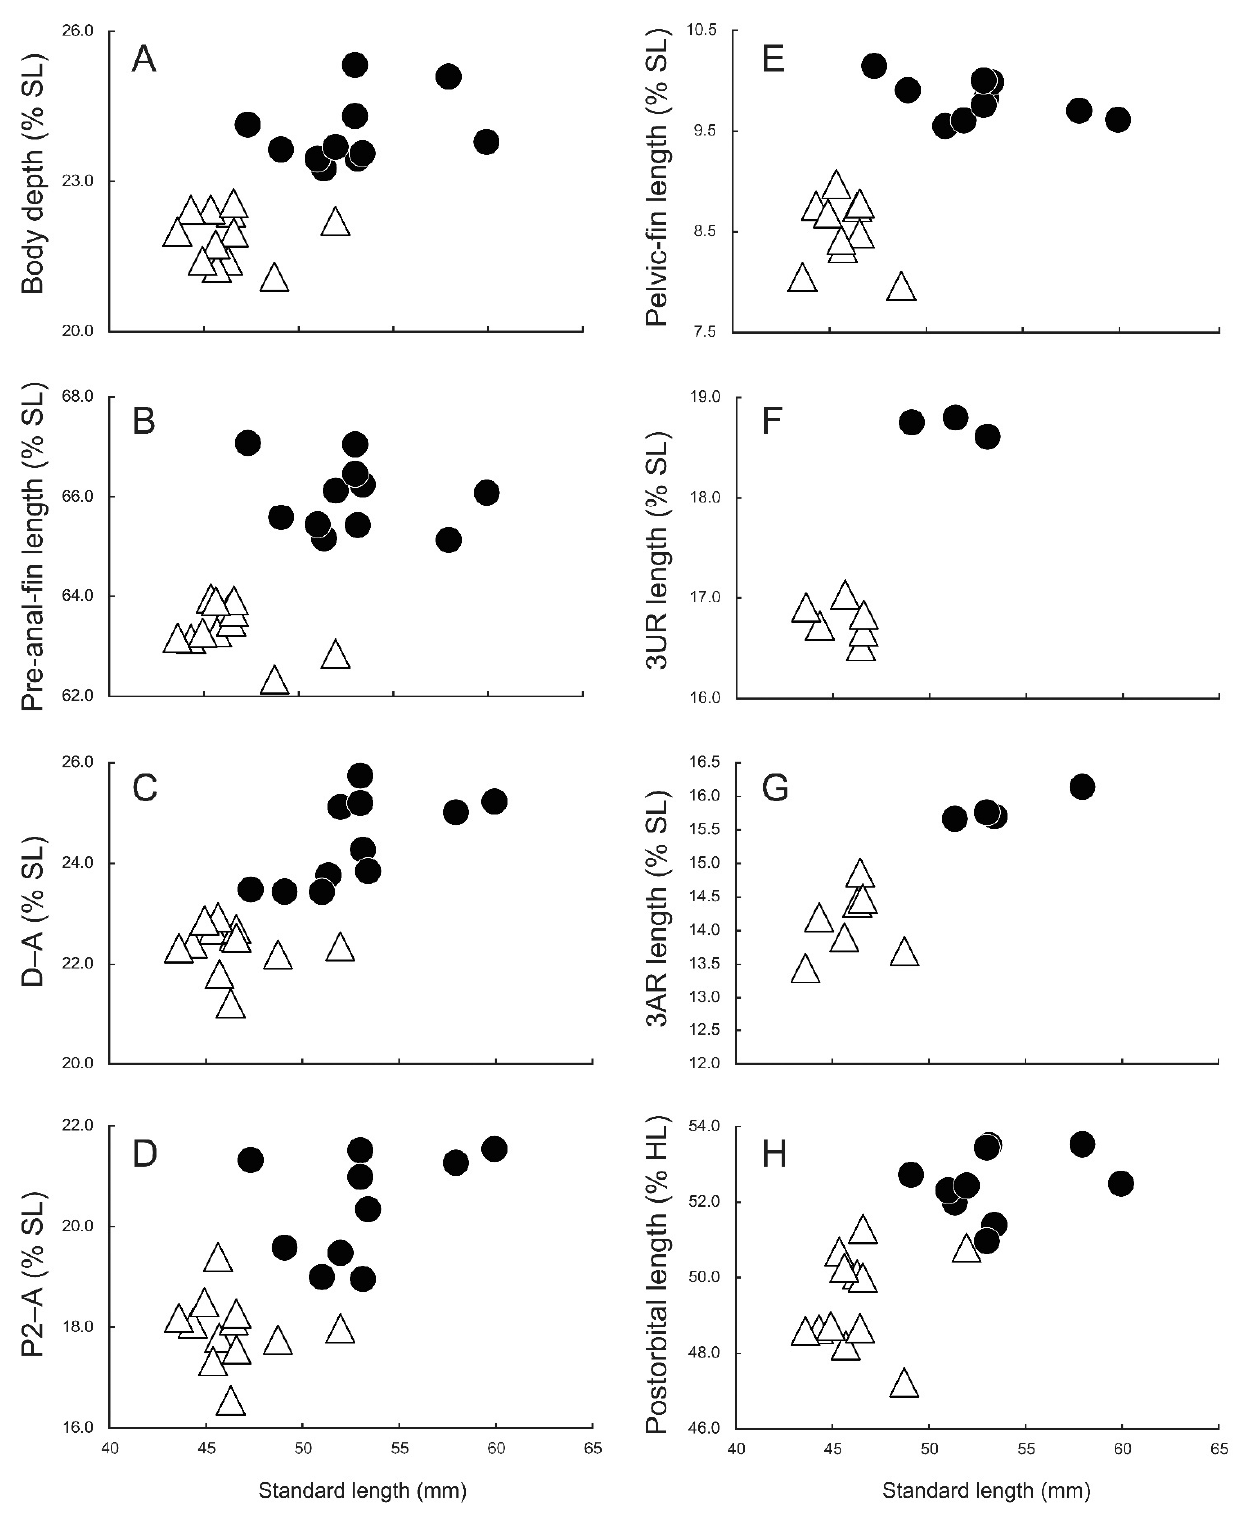
Figure 6. Relationships of ( A ) body depth (as % of standard length; SL), ( B ) preanal-fin length (as % of SL), ( C ) distance between origins of dorsal and anal fins ( A – D ) (as % of SL), ( D ) distance between pelvic-fin insertion and anal-fin origin (P2–A) (as % of SL), ( E ) pelvic-fin length (as % of SL), ( F ) third dorsal-fin ray (3DR) length (as % of SL), ( G ) third anal-fin ray (3AR) length (as % of SL), and ( H ) postorbital length (as % of head length) to standard length in Stolephorus ronquilloi (triangles) and S. hindustanensis (circles).